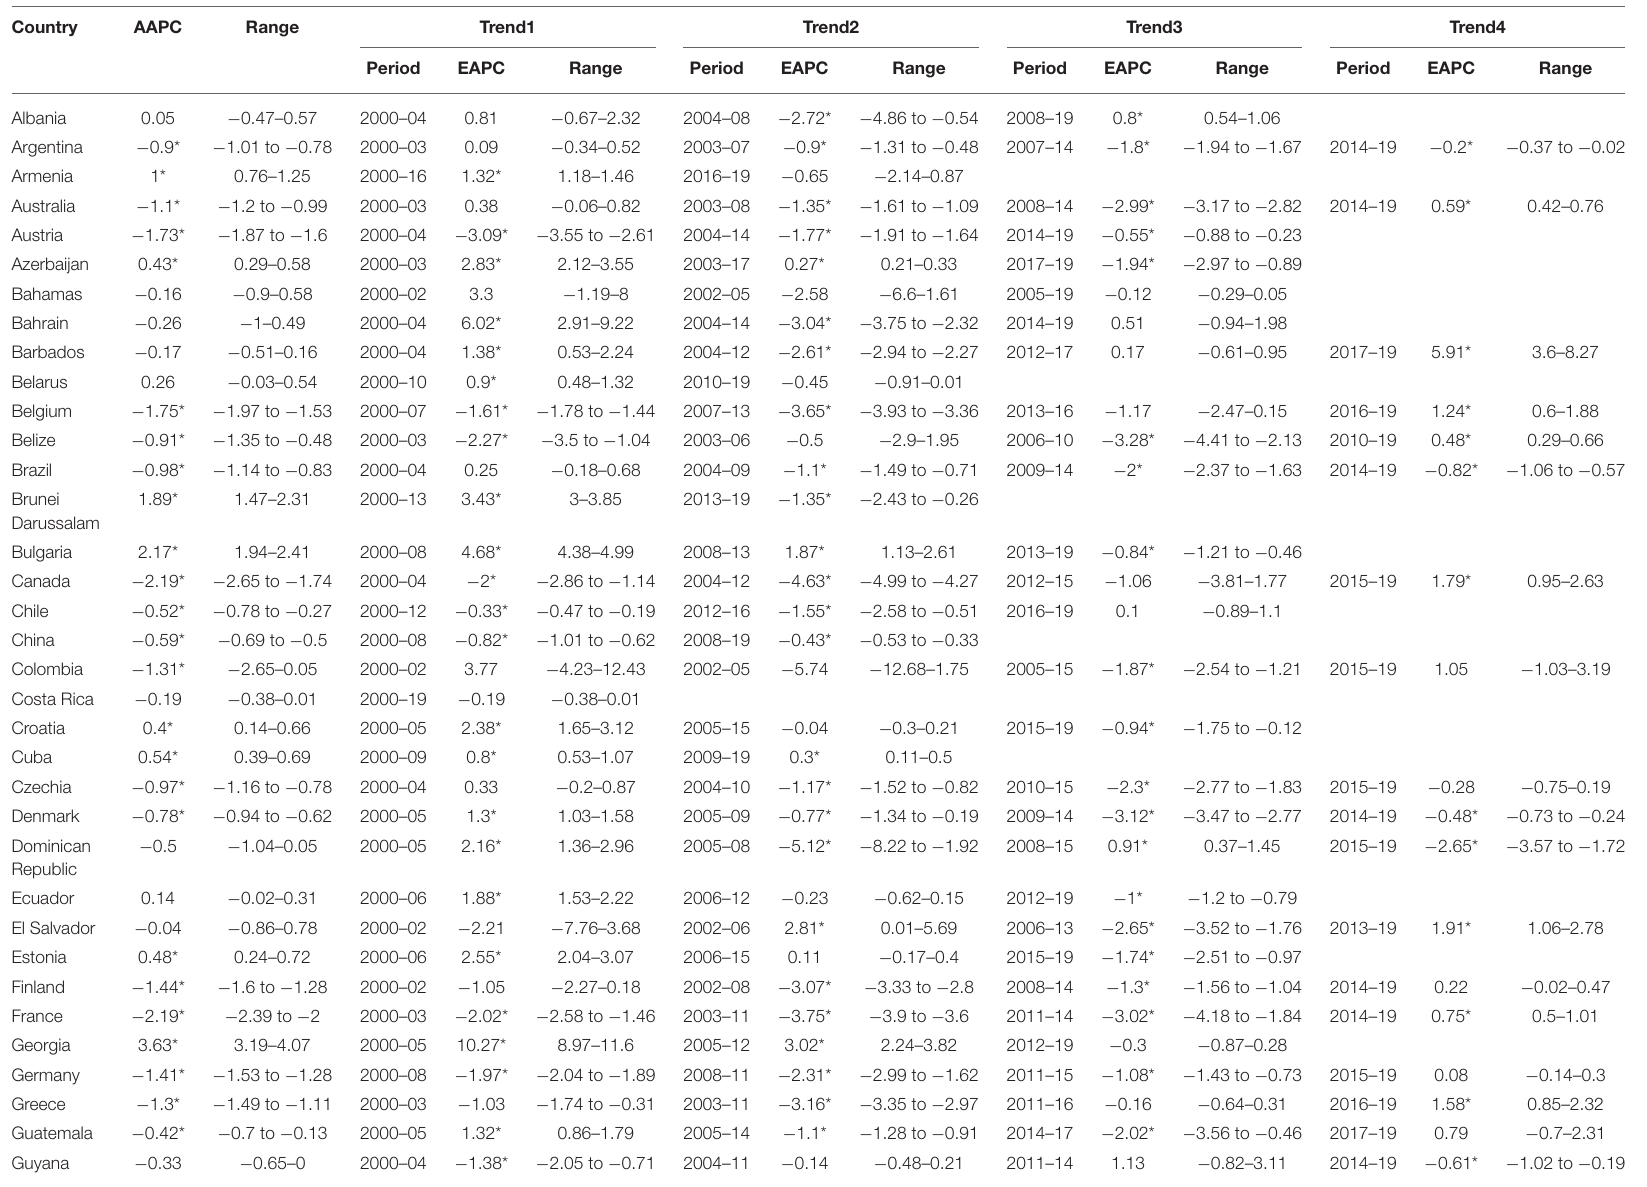
TABLE 4 | Trend analysis of age-standardized mortality for prostate cancer from 2000 to 2019. Country AAPC Range Trend1 Trend2 Trend3 Trend4 Period EAPC Range Period